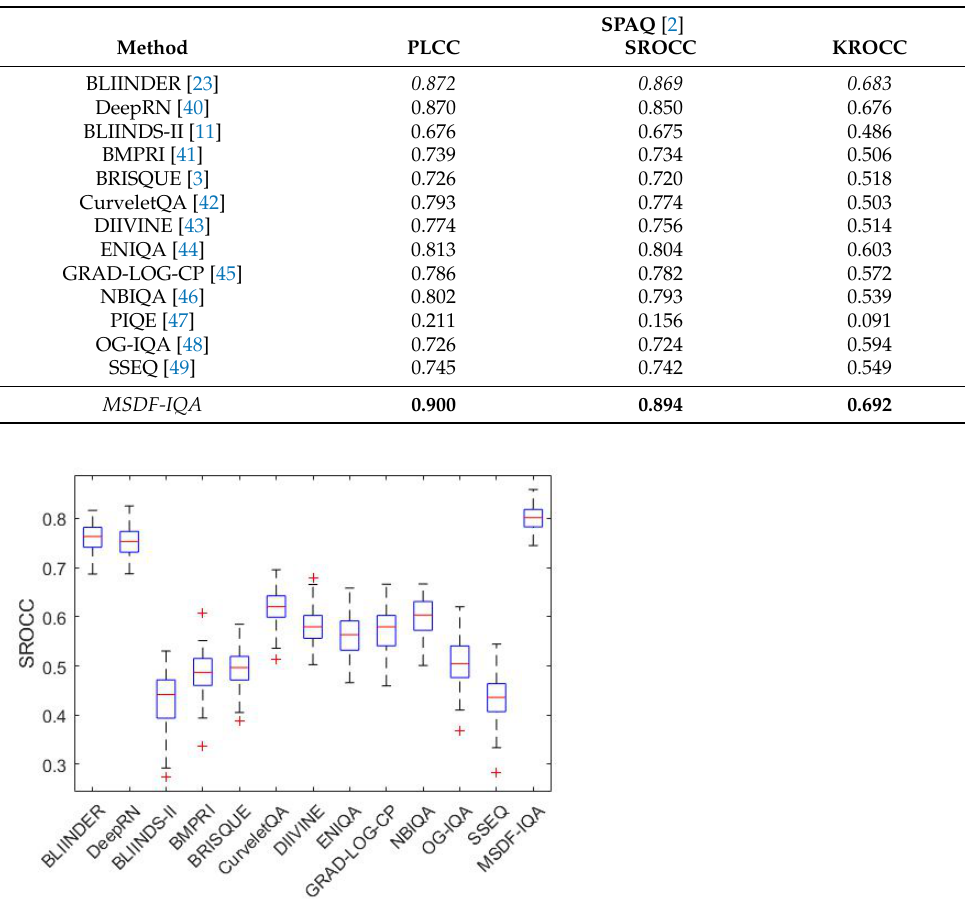
Figure 4. Boxplots of measured SROCC values on CLIVE [34]. The examined NR-IQA algorithms were evaluated over 100 random train–test